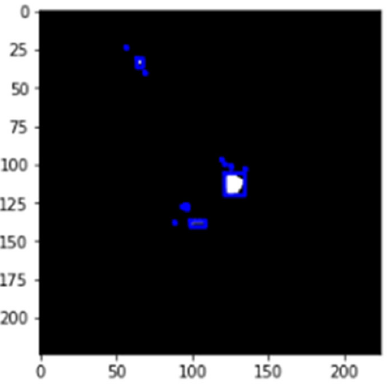
Figure 7. Drawing of bounding boxes around connected regions to extract the most effective color and cropped patches. These bounding boxes further selected the most dominant color region with a larger area.